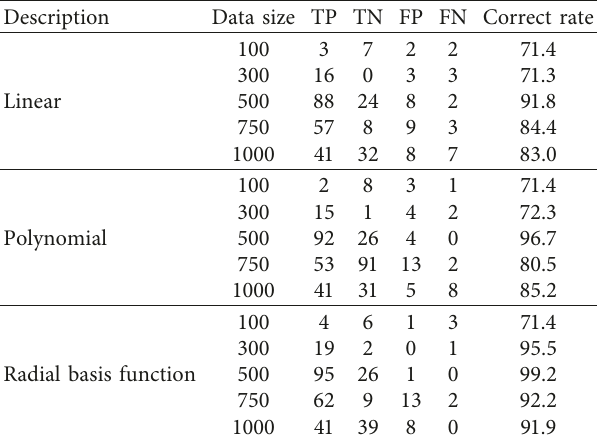
Figure 12: Polynomial SVM on a sample claims dataset. Table 5: Confusion matrix for SVM